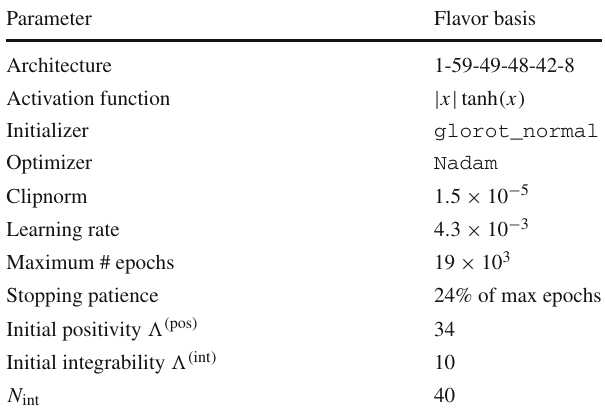
Table 1 The hyperparameter configuration selected using the k -folds hyperoptimization and used to perform the “feature scaling” fits pre- sented in this